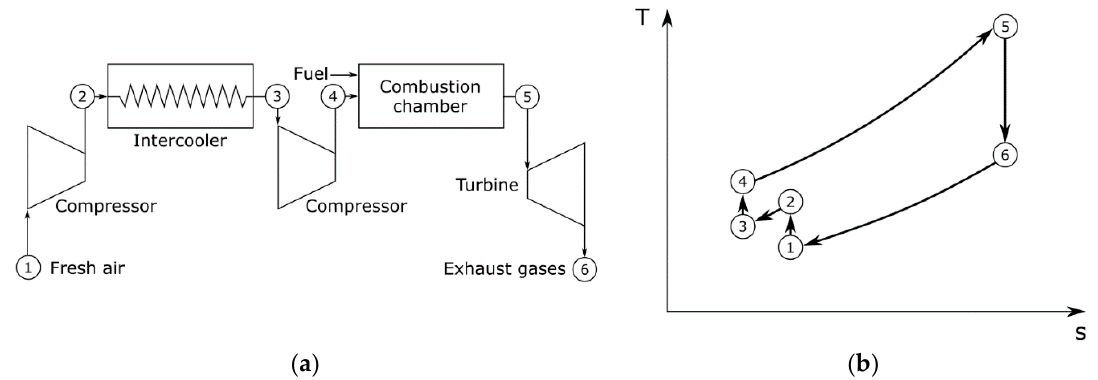
Figure 8. ( a ) Equipment and ( b ) T-s diagram of the ideal Brayton cycle with intercooling.